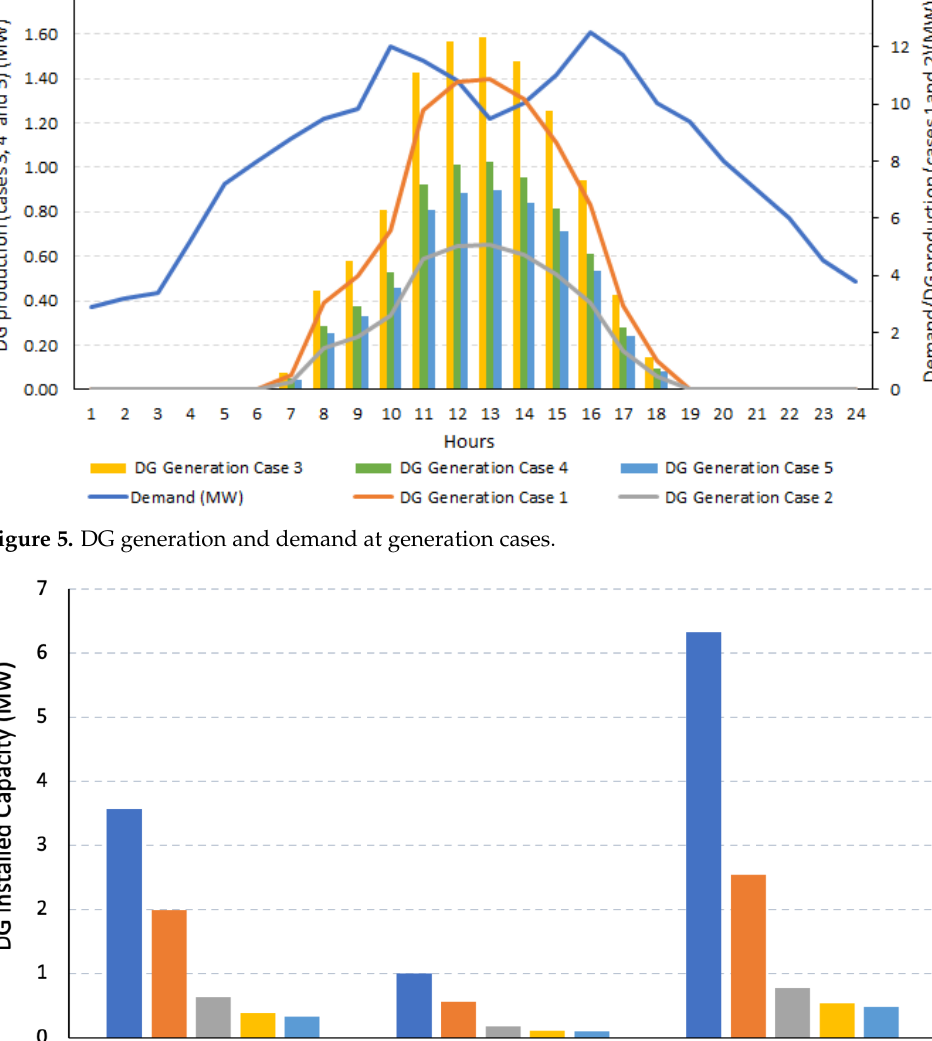
Figure 5. DG generation and demand at generation cases.